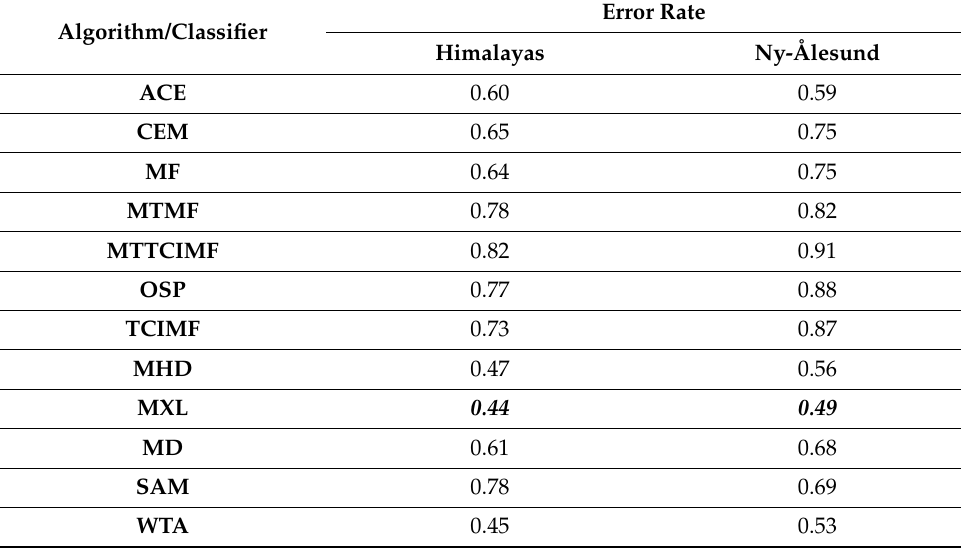
Table 9. Cumulative error rate independent of atmospheric corrections and pansharpening methods, calculated by averaging all the error rates over all processing schemes for individual test sites. The classifiers with the lowest error rate are emboldened and